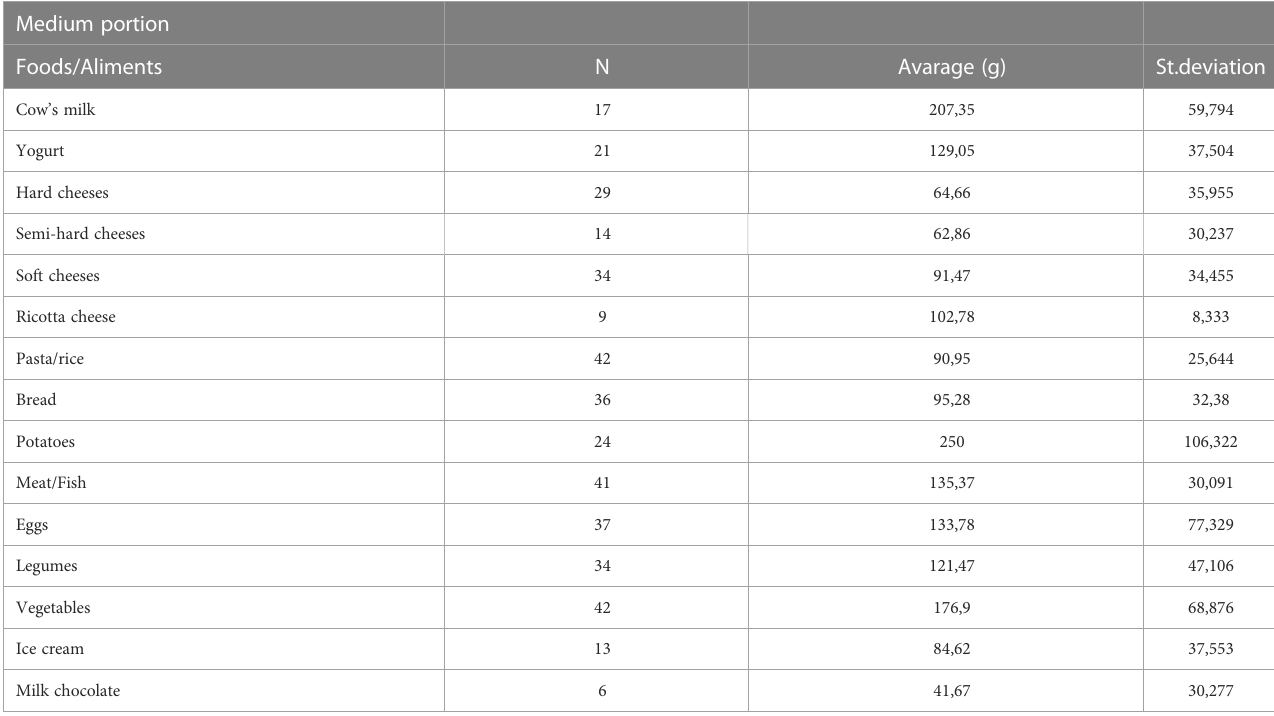
TABLE 7 Average portions of the different food groups.